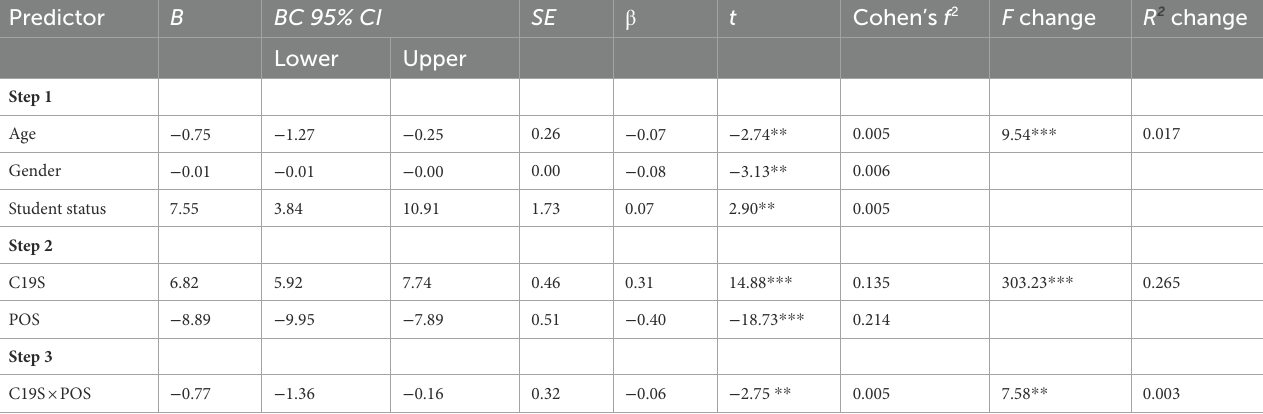
TABLE 5 Multiple regression analyses for the moderating effect of composite positive psychological factors (POS) on the relationship between COVID-19 Stress and depression. Predictor